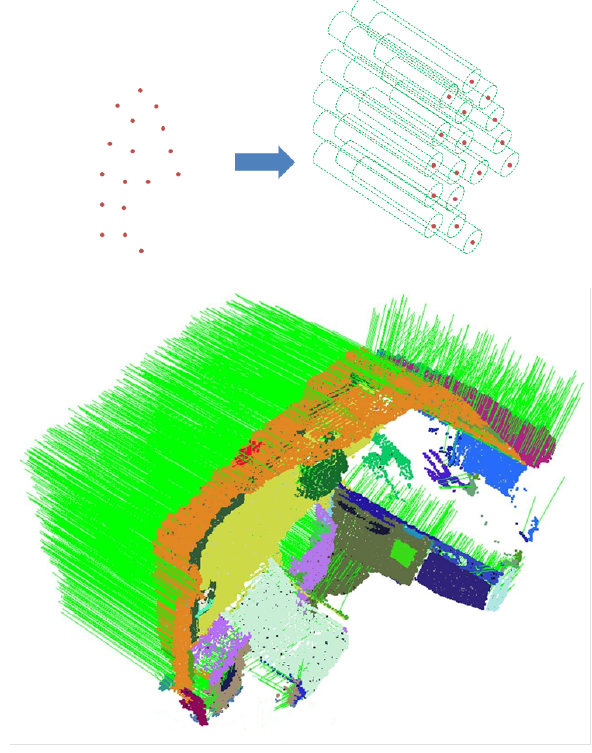
Figure 3: Application of SVPs. Top: using “sticks” (cylinders) to model the extrusion of a freeform patch. Bottom: example scene, in which the sticks are visualized as their axes (green beams).